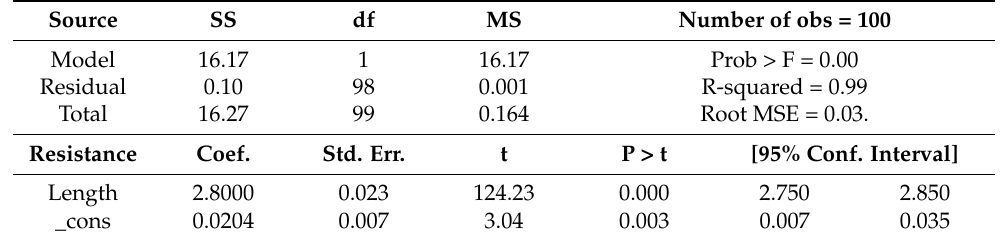
Table 2. Regression overview of length-dependent electrical resistance of SCV conductive yarn.